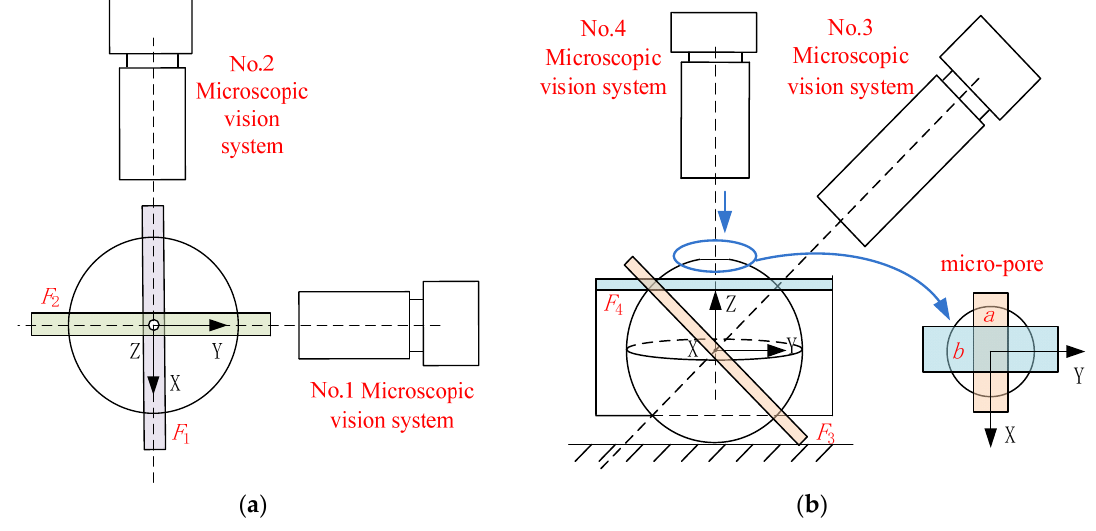
Figure 3. Sketch map of monitoring model: ( a ) horizontal direction; ( b ) 60-degree direction. The monitoring model of the horizontal microscopic vision is shown in Figure 3a.